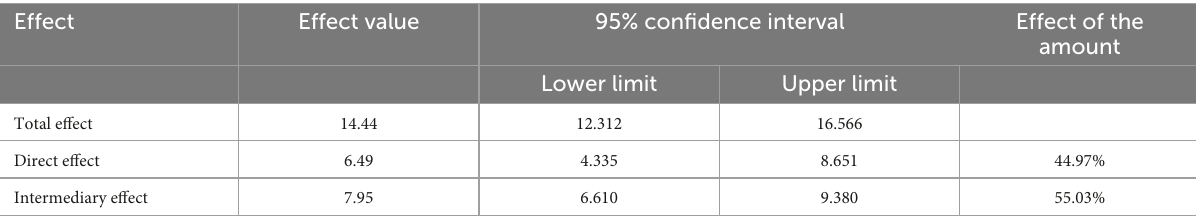
TABLE 4 Bootstrap analyses of the mediation